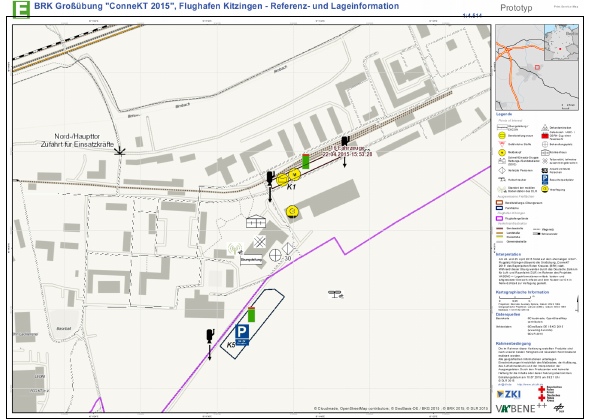
Figure 6. Automatically generated map product